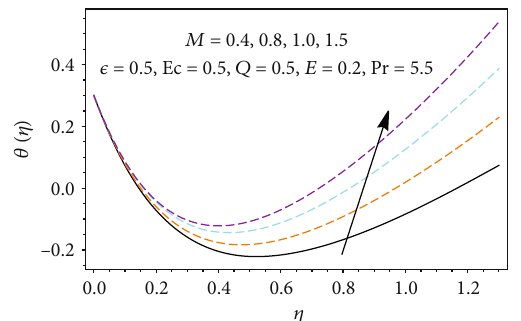
Figure 3: Illustration of the in fl uence of the ε on f ′ ð η Þ .